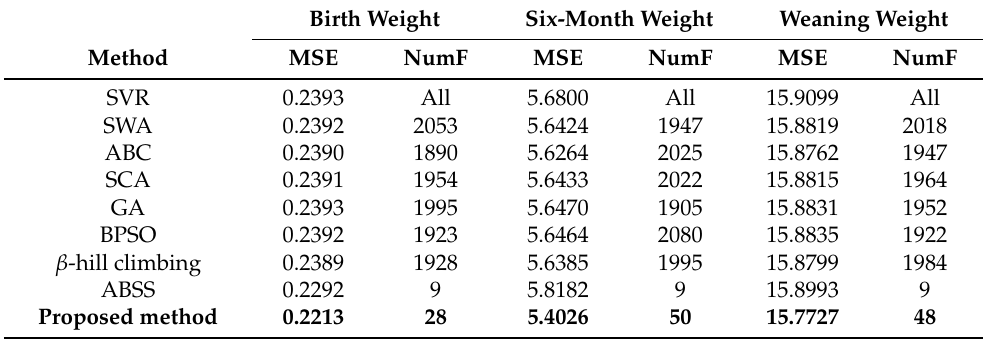
Table 3. Performance of feature selection methods for predicting the body weights on three